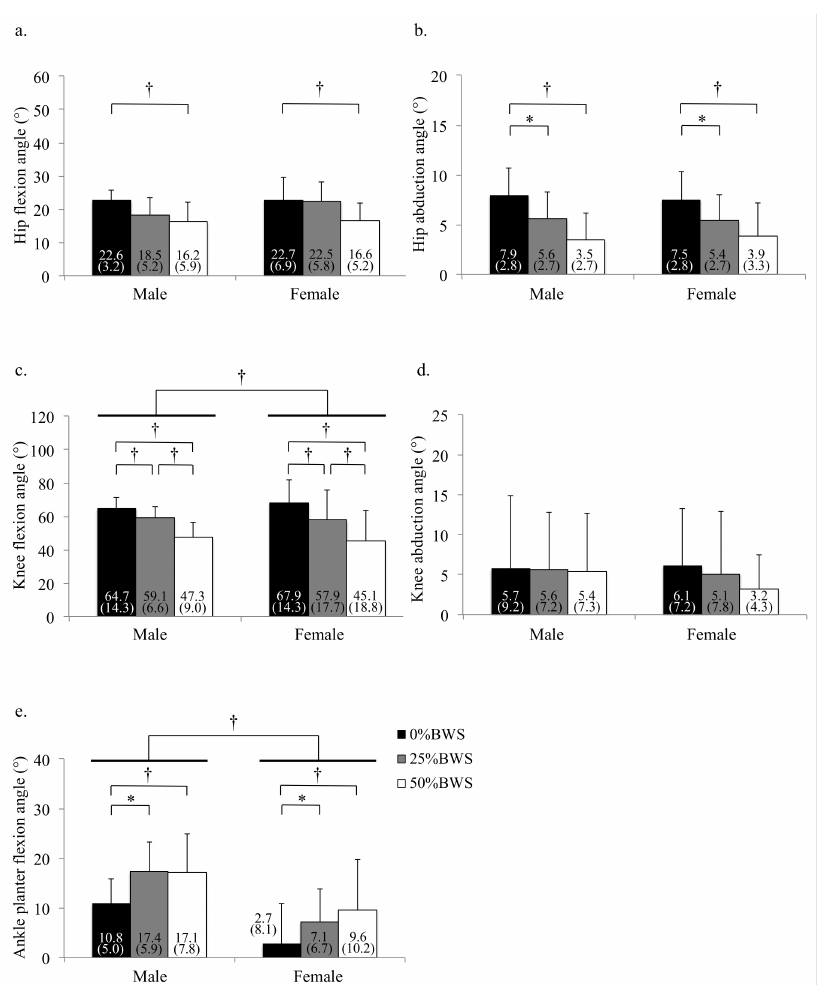
Figure 8. The peak angle of each joint during swing phase under 0%, 25% and 50%BWS conditions for male and female participants (( a ) hip flexion, ( b ) hip abduction, ( c ) knee flexion, ( d ) knee abduction, ( e ) ankle plantar flexion). Data are reported as mean (standard deviation). * p < 0.05, † p < 0.01, BW: body